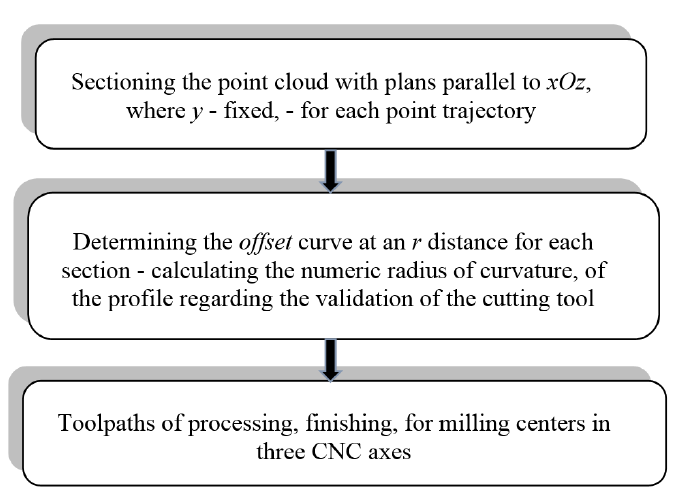
Figure 1. Methodology for generating finishing toolpaths using ordered point cloud.